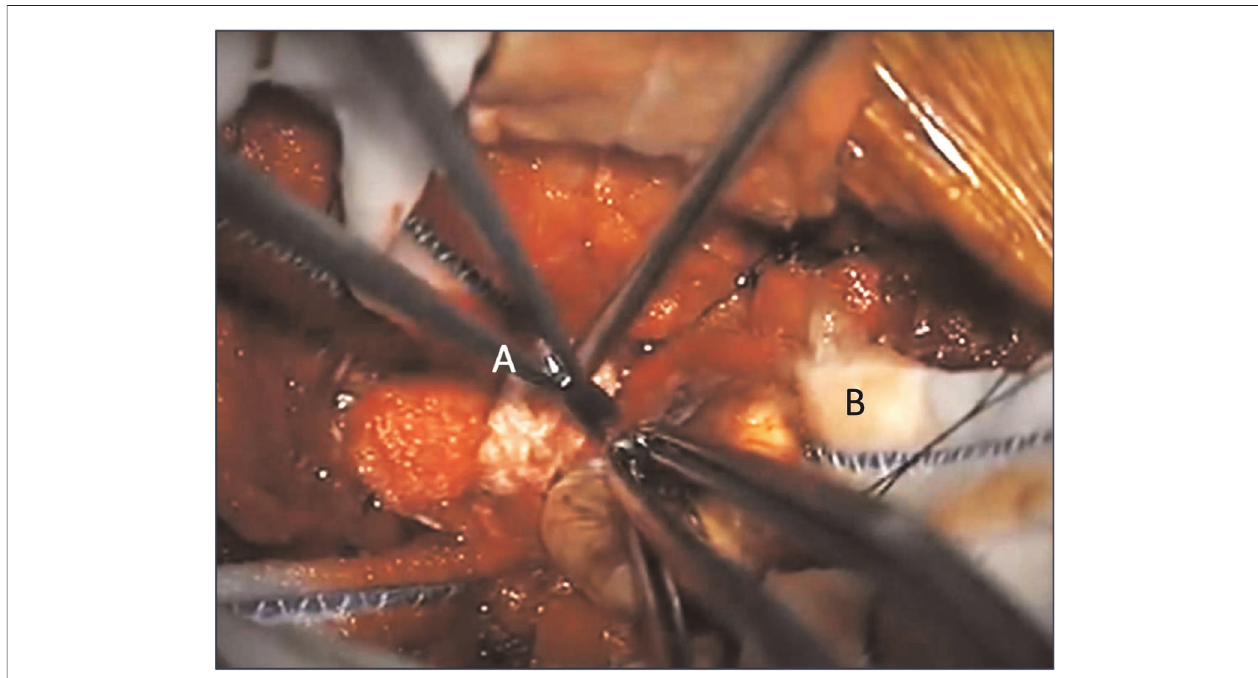
FIGURE 1 | Example screenshot from a spinal surgery operative video, where a nerve sheath tumour is being excised. Participants in the study were asked to focus on and count how many times the scissors ( A ) were used to cut in the attention task. They were then asked to identify the number of cottonoid patties ( B ), outside of their focus, left in the surgical site at the end of the video in the inattention task. Absolute error scores were calculated by taking the difference between the stated and actual count. (Full video available at https://www.youtube.com/watch?v=dGeSd5hU1tw, Prof. Ali Bydon, Johns Hopkins Medicine, uploaded 18th July, 2012. Image reproduced here with permission from the